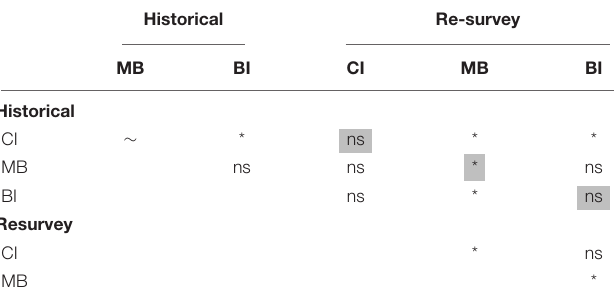
TABLE 3 | Pairwise significance of PERMDISP analyses.